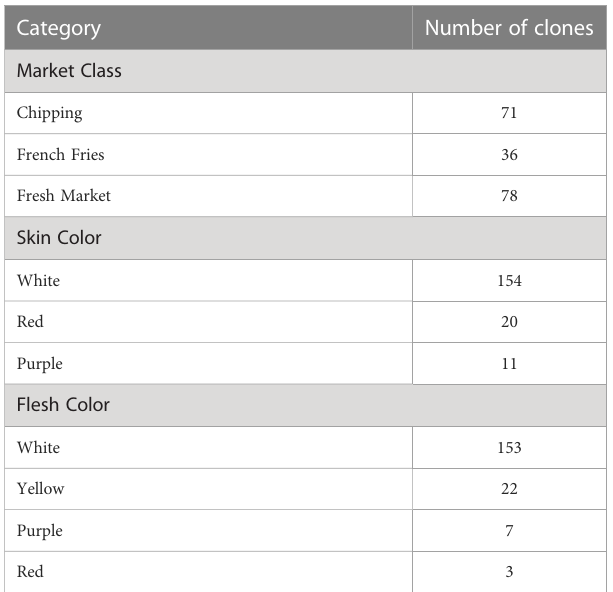
TABLE 1 Characteristics of the 185 potato clones used for GWAS in this study, broken down separately by market class, skin color, and fl esh